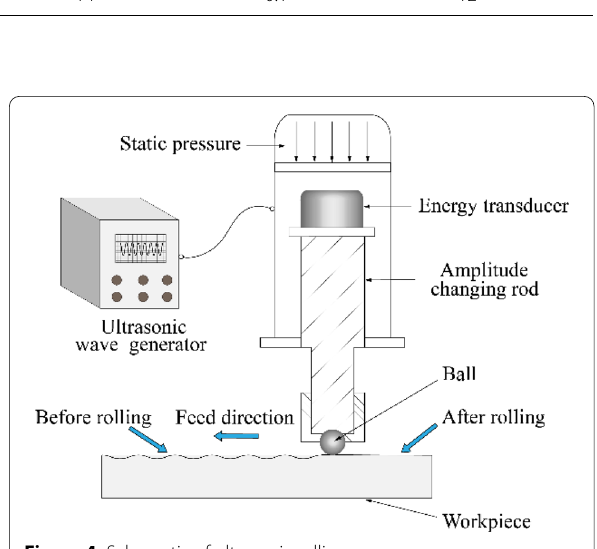
Figure 4 Schematic of ultrasonic